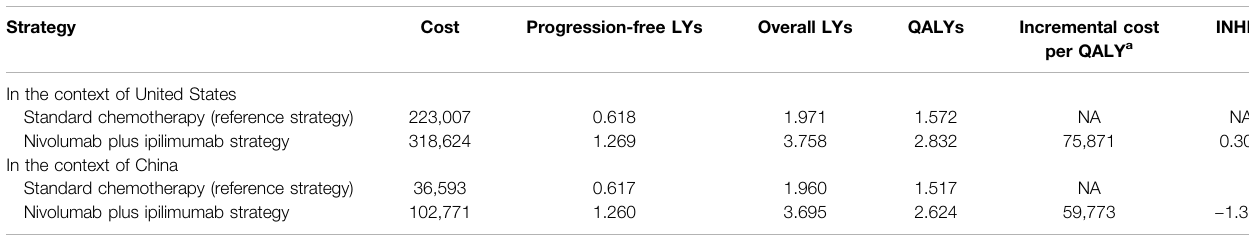
TABLE 2 | Summary of cost ($) and outcome results in base-case analysis.